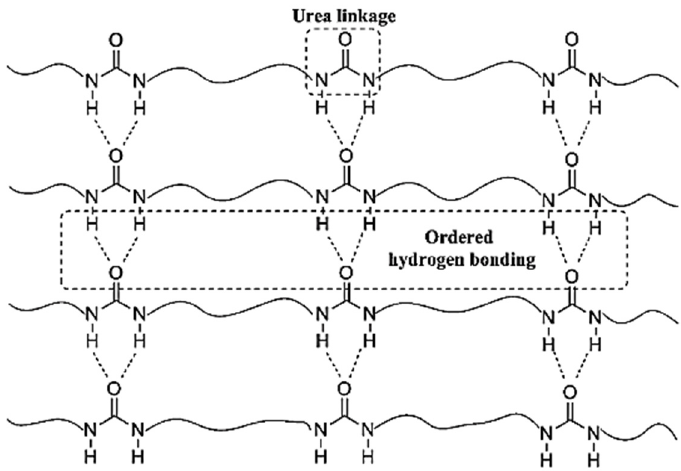
Figure 18. The network structure of the polyurea-HDA. From reference [48].